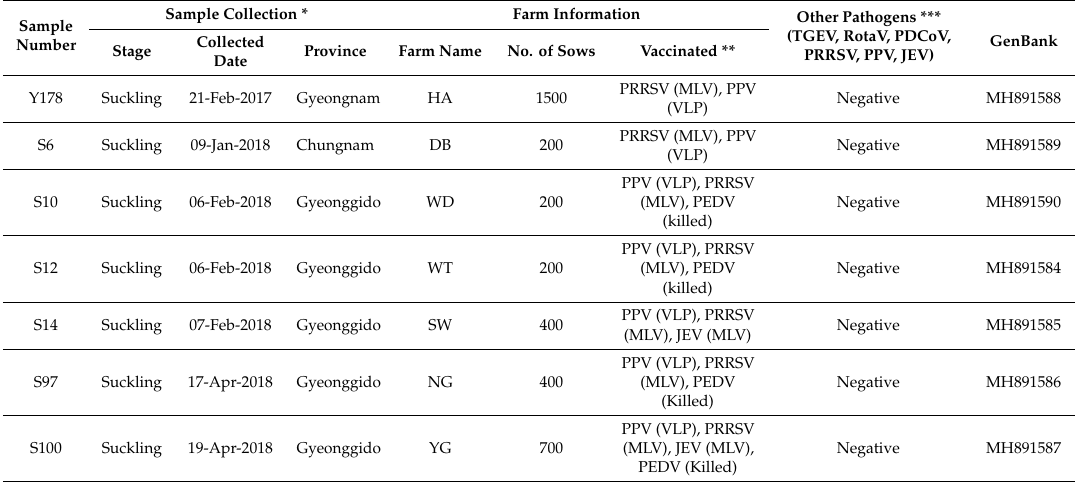
Table 1. Information of PEDV positive samples in this